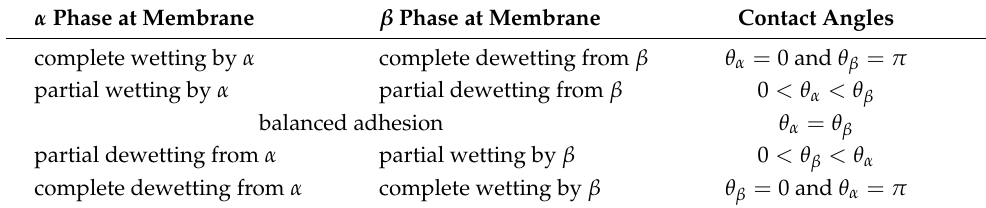
Table 1. Relations between the apparent contact angles θ α and θ β for the different wetting regimes displayed in Figure 9. The first column describes the wetting behavior of the α phase, the second column the wetting behavior of the β phase, and the last column the relation between θ α and θ β . α Phase at Membrane β Phase at Membrane Contact Angles complete wetting by α complete dewetting from β θ α = 0 and θ β = π partial wetting by α partial dewetting from β 0 < θ α < θ β balanced adhesion θ α = θ β partial dewetting from α partial wetting by β 0 < θ β < θ α complete dewetting from α complete wetting by β θ β = 0 and θ α =